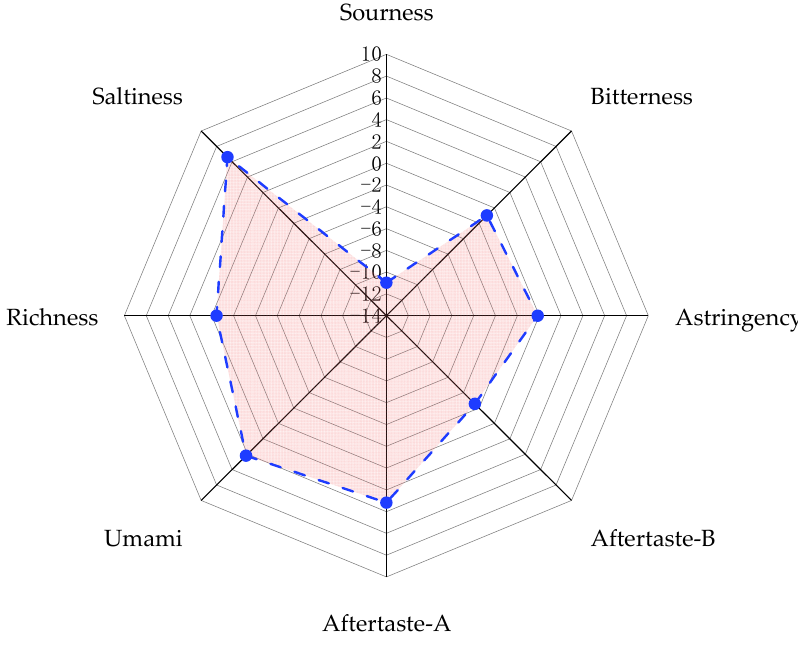
Figure 4. Spider plot for electronic tongue sensory score of potato blueberry yogurt.